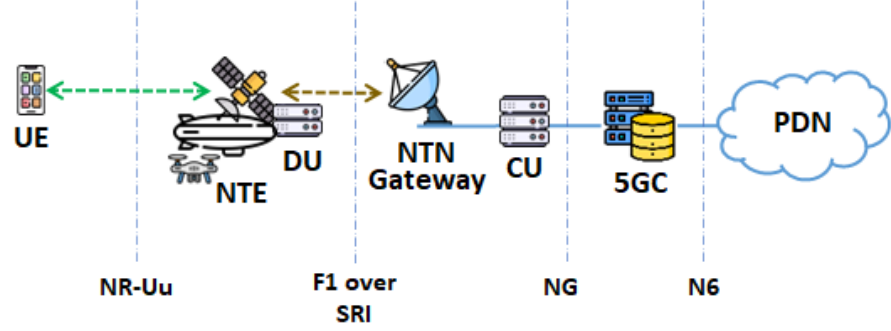
Figure 8. On-board distributed unit NTN architecture.